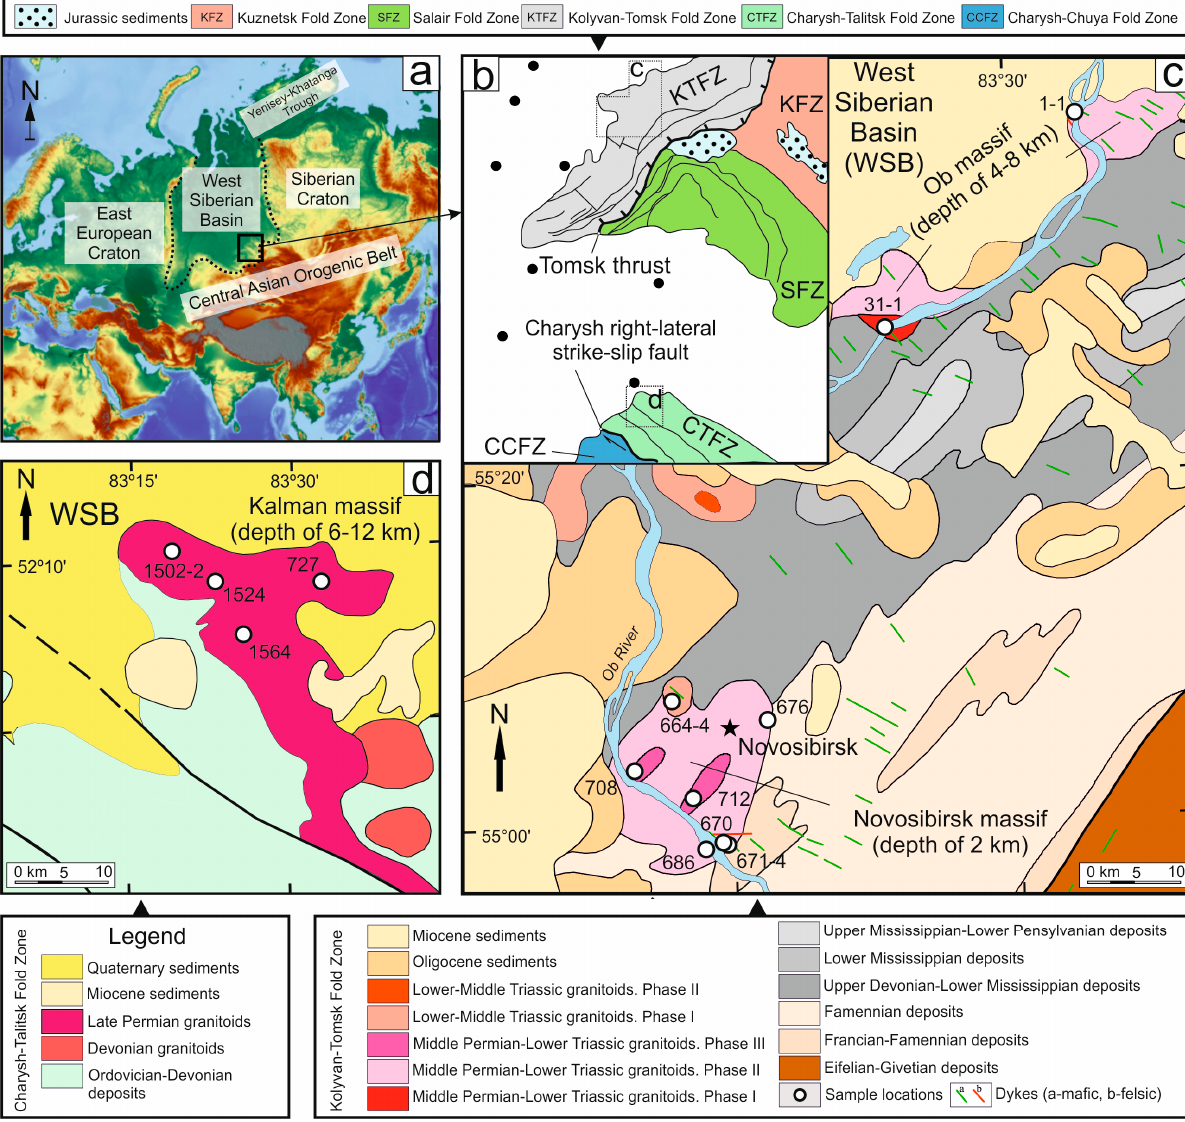
Figure 1. ( a ) Geographic map of Eurasia showing position and topography of the West Siberian Basin (WSB) ( b ). Tectonic map of the southeasternWSB showing position of the exposed basement segments and locations of the boreholes that give insight to stratigraphy of the southeastern WSB. ( c ) Geological position of the Ob and Novosibirsk massif (after [7,8]) and ( d ) geological position of the Kalman massif (after [7,9]) with indication of sample locations. Depth of “n” km means depth of the massif root according to geophysical data [7].